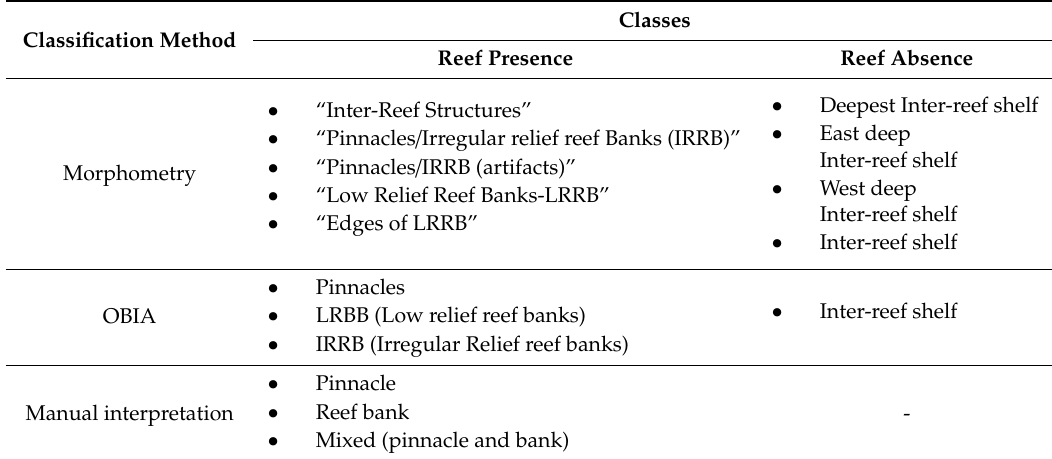
Table 3. Classes adopted for each classification method.